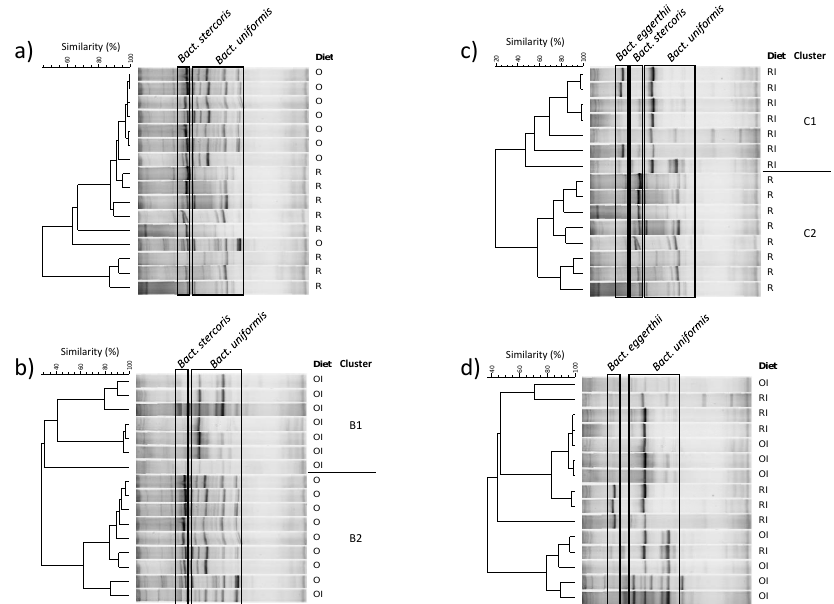
Figure 3. DGGE banding patterns of caecal Bacteroides population. Frames depict gel positions assigned to a specific bacterial taxon based on band sequencing (see Supplementary Information, Figure S1).